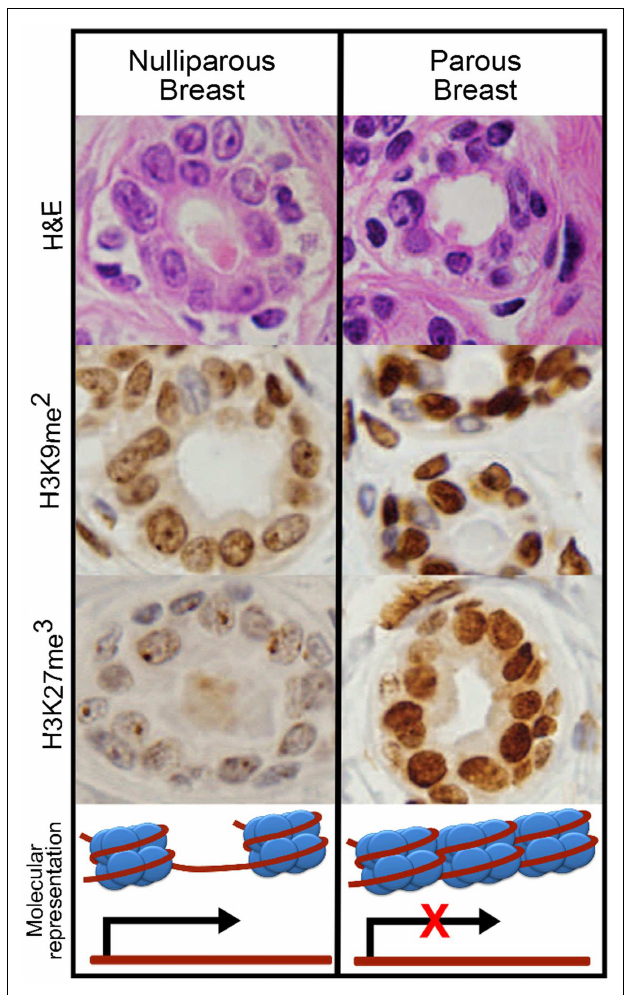
FIGURE 1 | Epithelial cells of nulliparous and parous post-menopausal breast . As observed with hematoxylin and eosin staining (H&E), the cells from nulliparous breast (left) contain nuclei with less condensed chromatin (euchromatin) compared to the nuclei of parous women (right).The parous breast contains darker nuclei as a consequence of chromatin compactation (heterochromatin). Immunohistochemistry revealed higher levels of dimethylation of lysine 9 and trimethylation of lysine 27 in histone 3 (H3K9me 2 and H3K27me 3 ) in the parous breast, which have been linked with gene silencing due to chromatin